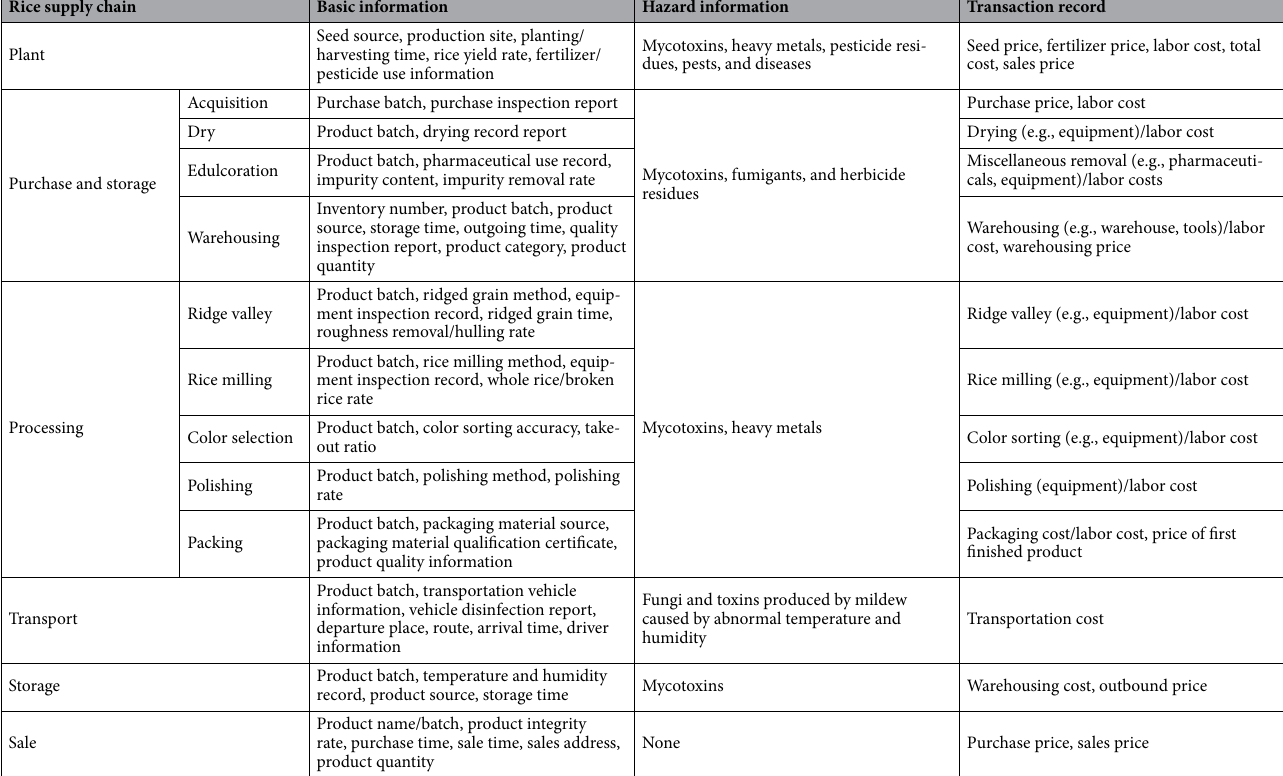
Table 2. Classification table of key information of the whole rice supply chain.